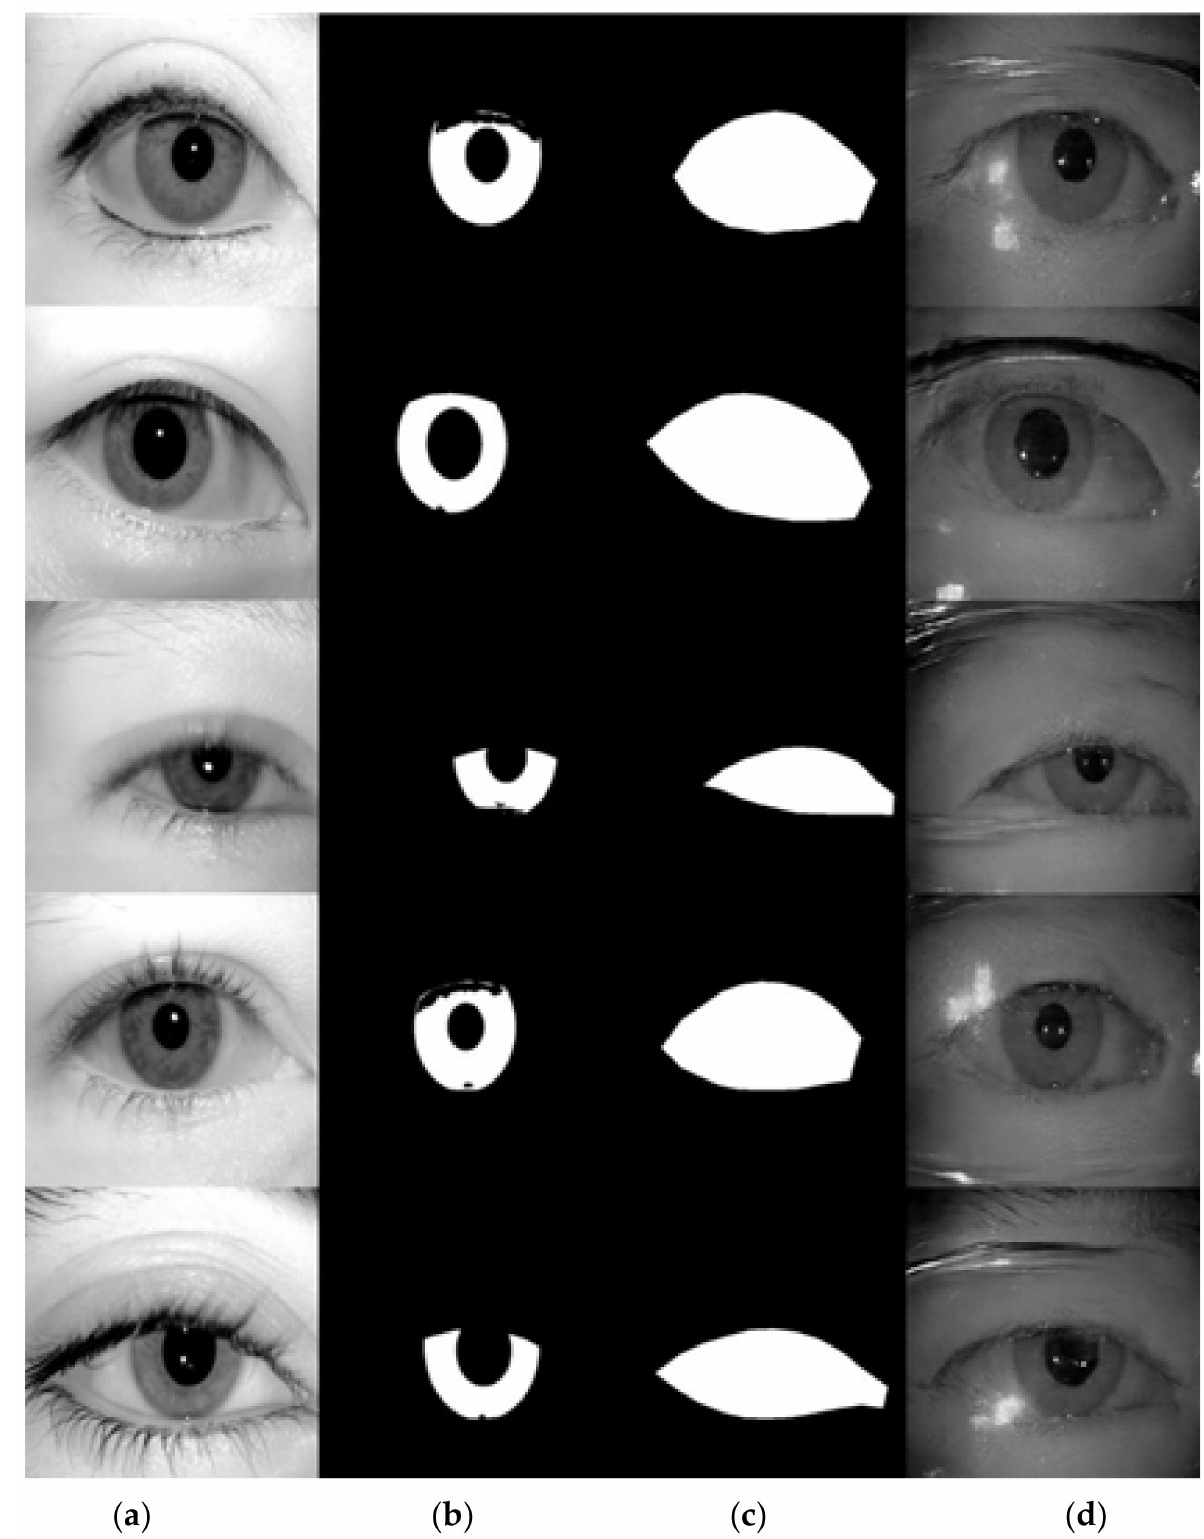
Figure 15. The examples of generated images (trained with ICE dataset, with glasses). ( a ) original iris image; ( b ) ground-truth label for iris; ( c ) ground-truth label for periocular region; ( d ) generated images using ( b , c ) as the conditional inputs to the proposed image generation